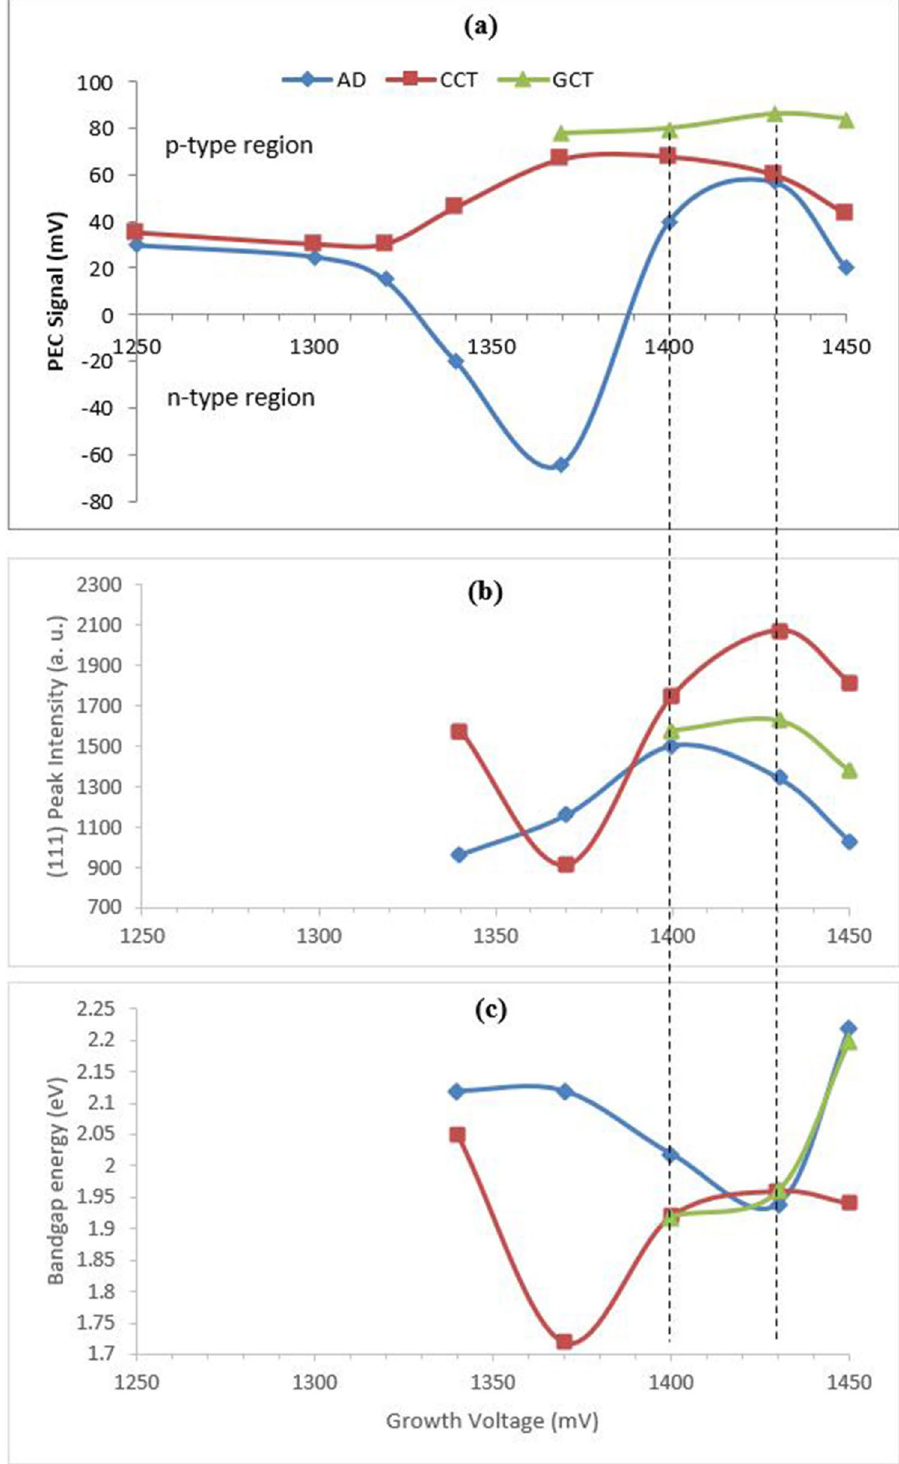
Figure 8. Variation of (a) PEC signal, (b) XRD intensity of (111) peak and (c) bandgap energy as a function of cathodic deposition potential for as-deposited (AD), CdCl 2 -treated (CCT) and GaCl 3 -treated (GCT) CdMnTe layers grown between 1250 – 1450 mV cathodic